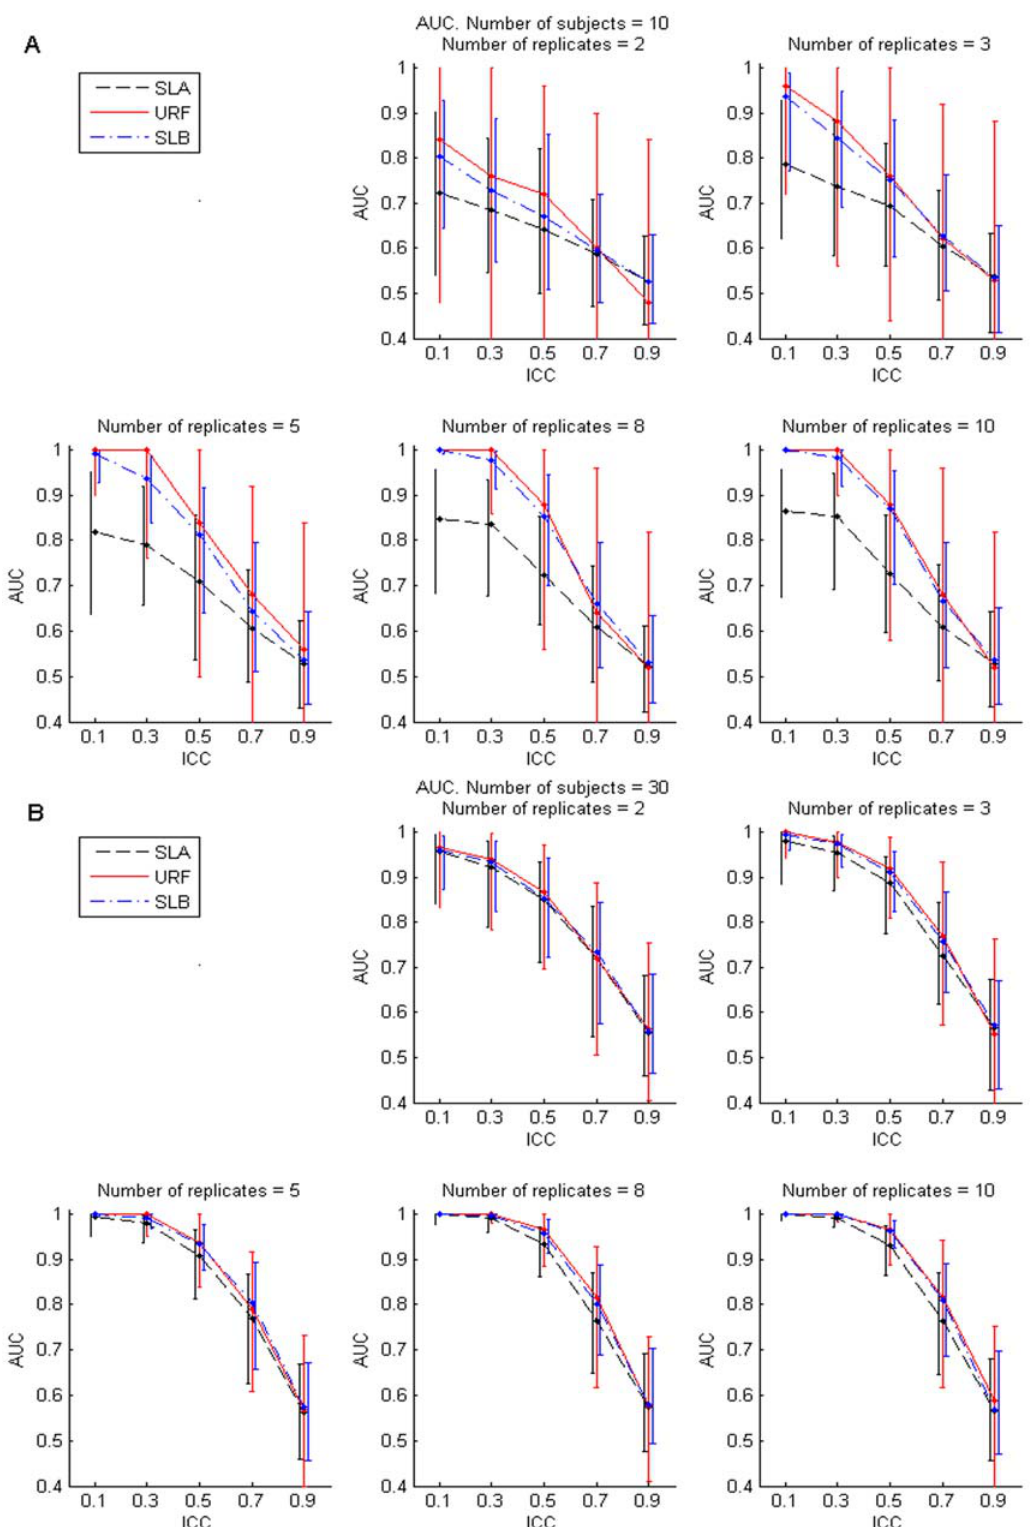
Figure 3. Area under the receiver operating characteristic curve (AUC). Median and the 5th and 95th percentiles of the AUC for 200 simulations (see text) with forests grown on ten subjects (panel A) and 30 subjects (panel B). The median is depicted by a dot, and vertical bars represent the 5th and 95th percentiles. Vertical bars are separated artificially along the x-axis to improve visual representation. Results for SLB and URF forests grown on subject-level bootstrapped data correspond to dot-dashed blue and solid red lines, respectively. The dashed black lines correspond to SLA.